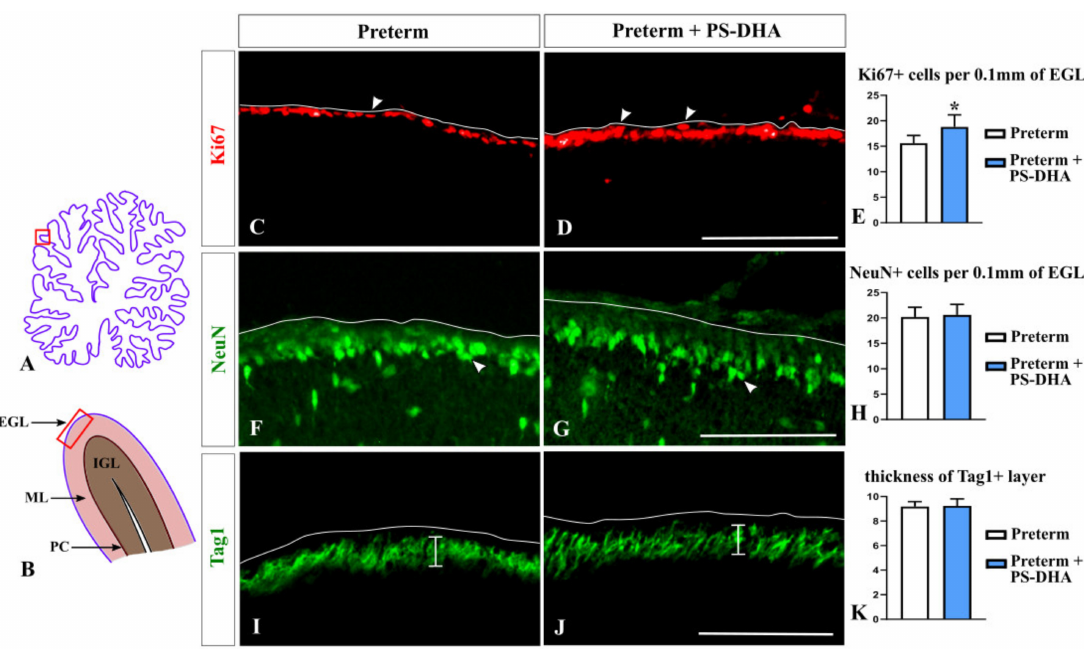
Figure 1. Expansion of undi ff erentiated (Ki67 + ) cerebellar granule cell precursors in preterm pigs fed by PS-DHA. ( A , B ) Schematic of midsagittal section of the newborn pig cerebellum ( A ). Panel B shows a higher magnification of the region boxed in panel A. EGL, external granule cell layer, ML, molecular layer, PC, Purkinje cell layer, IGL, internal granule cell layer. Panels C, D, F, G, I, J display immunostained sections that correspond to the region shown by the box in panel B. The outer cerebellar surface is depicted by the white line. Sections shown in panels C, D, F, and G were photographed under 10 × magnification. Sections shown in panels I and J were photographed under 20 × magnification. ( C – E ) Undi ff erentiated progenitors in the EGL identified by Ki67 immunostaining (arrowheads in ( C , D )) were increased in the number in preterm pigs that received PS-DHA ( E ). n = 5 pigs per group, * p < 0.05, ( F – H ) Arrowheads point to di ff erentiating (NeuN + ) progenitors in the EGL ( F , G ). The numbers of NeuN + EGL cells were similar in the control and experimental groups ( H ). n = 5